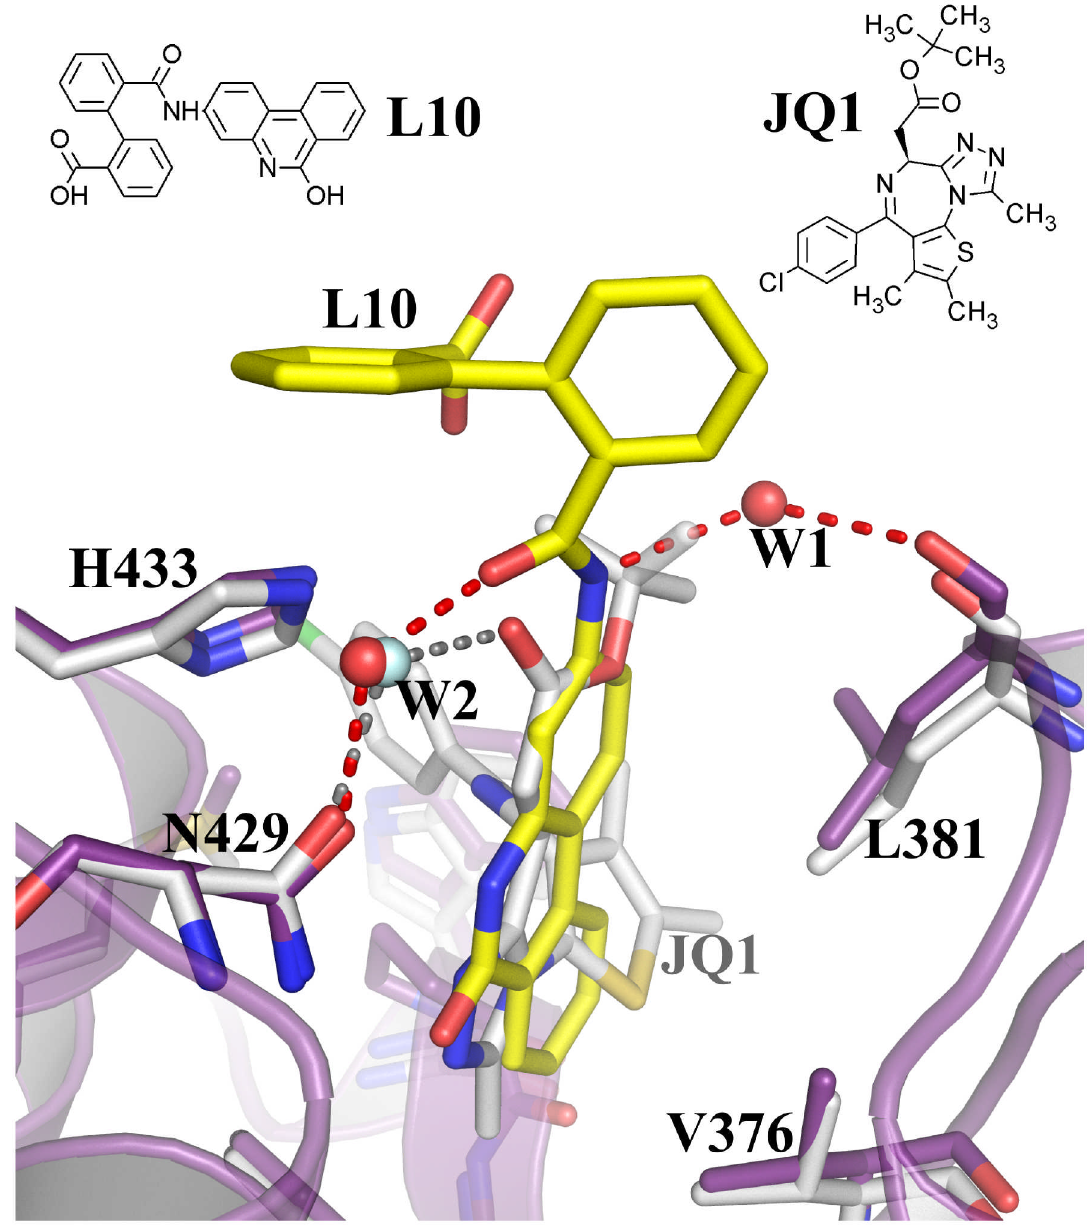
Fig 8. Comparison of water bridged interactions formed in the JQ1 and L10 complexes at the edge of the binding pocket. Two water molecules (W1 and W2) are demonstrating water bridged hydrogen bonds (red) in the BD2-L10 complex. A single water mediated hydrogen bond is observed in the case of JQ1 (grey). Compound L10 is shown in yellow. The residues corresponding to BD2-L10 and BD2-JQ1 are shown in purple and grey, respectively. The ligands and the interacting residues are shown as sticks. Water molecules are shown as spheres. The hydrogen bonds are shown as broken